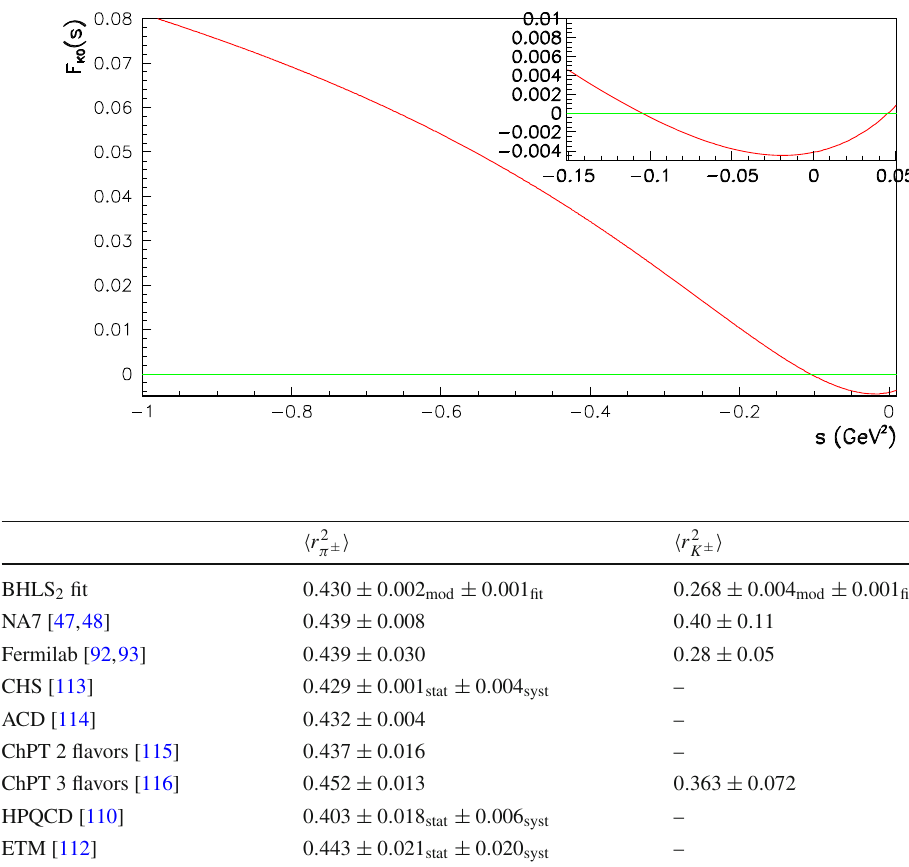
Fig. 9 The neutral kaon electromagnetic form factor predicted by BHLS 2 : The function is computed at the central value of the fit parameters